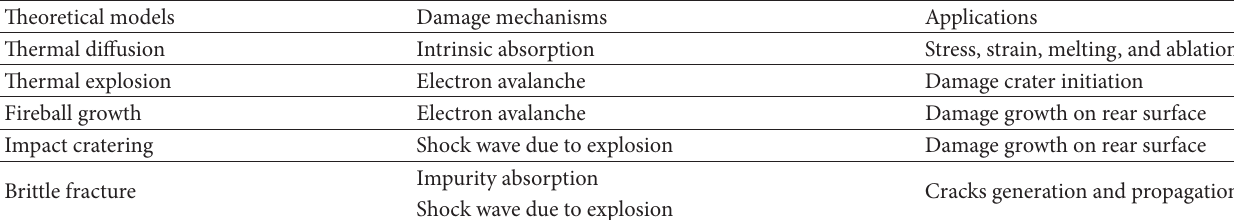
Table 2: Theoretical models of laser-induced